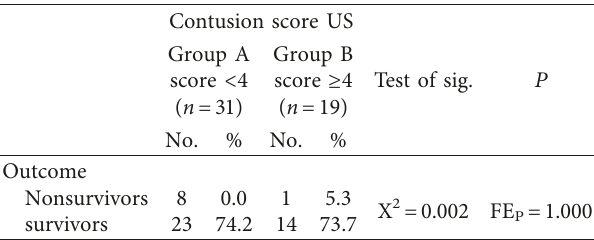
Table 6: The severity of lung contusion and